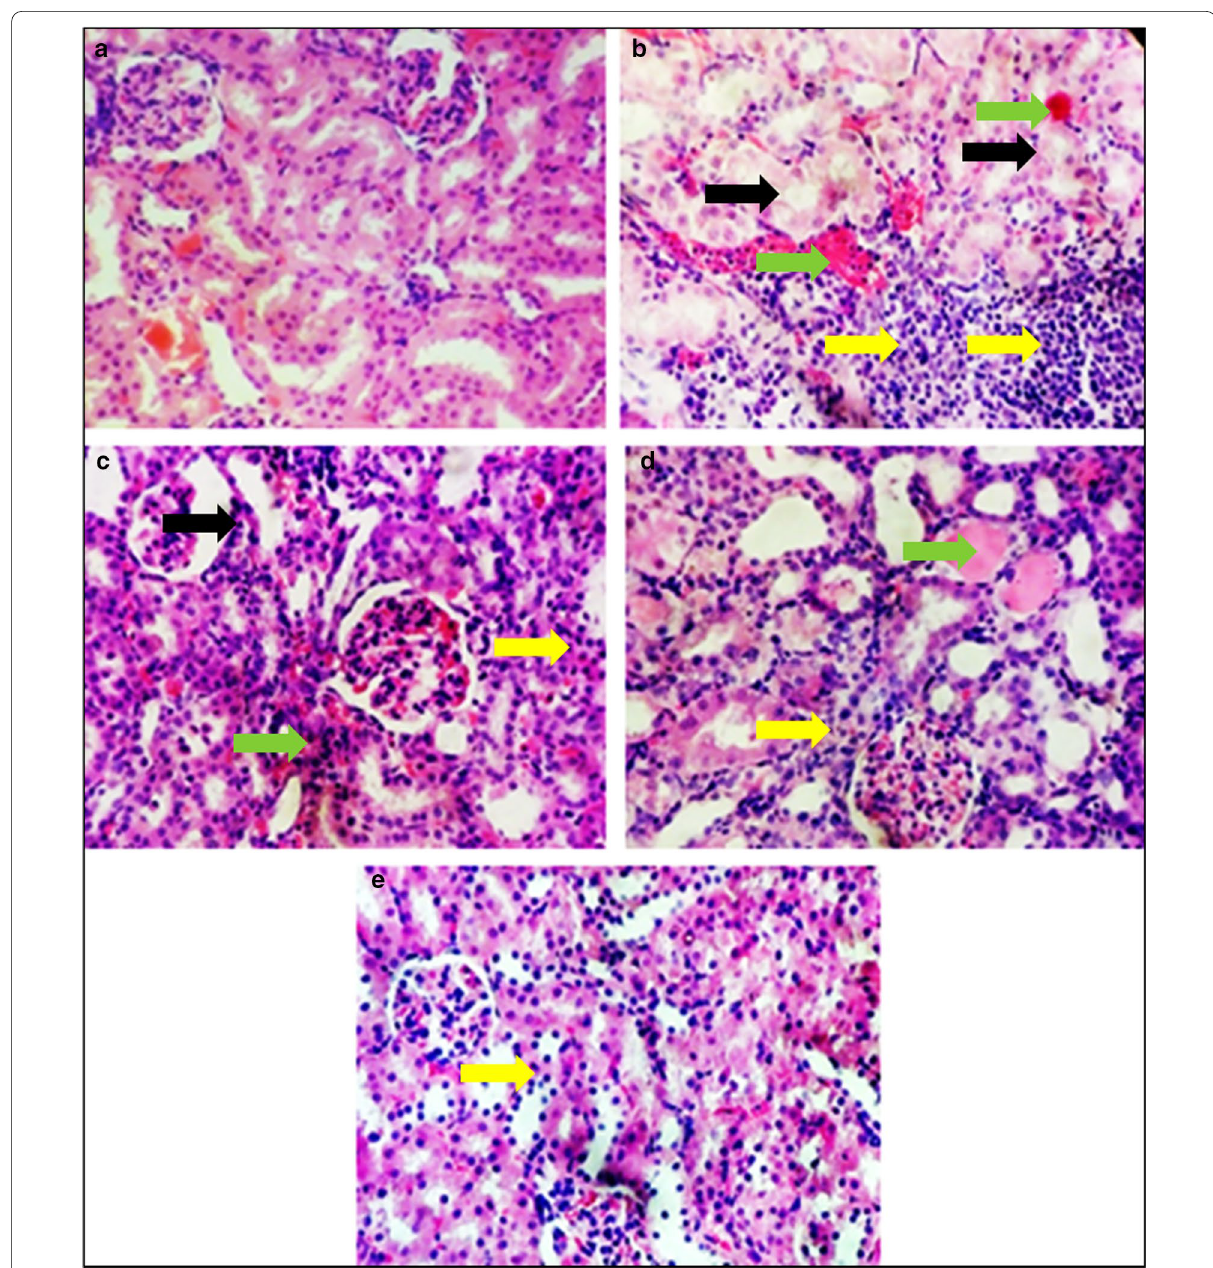
Fig. 8 Histopathological results of kidney sections stained with H & E in GM induced renal damage in rats ( d : DG (40); DG (80). Black arrow indicates: Degeneration and necrosis in renal tubules; Yellow arrow indicates: inflammatory cells infiltration (neutrophils); Green arrow indicates: inter-tubular